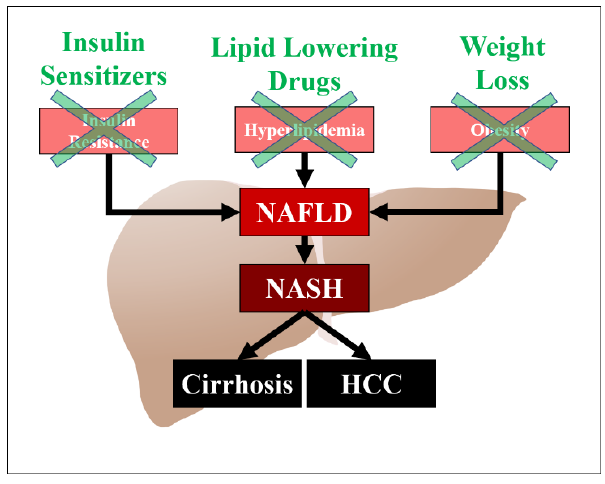
Figure 1 . Pathogenesis of NAFLD/NASH and potential targets for treatment. HCC (Hepatocellular carcinoma).